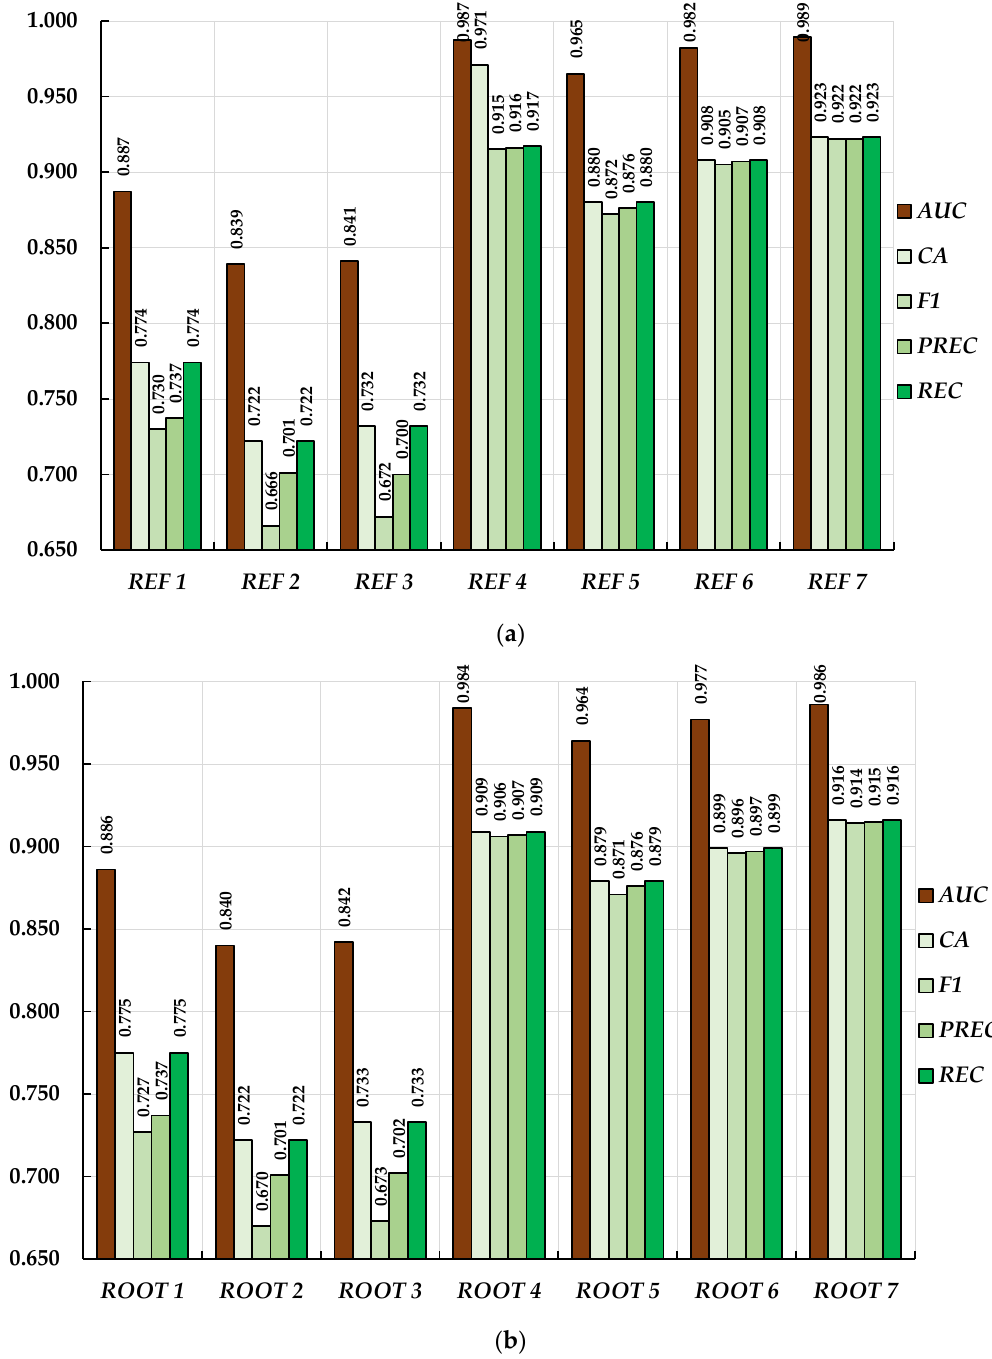
Figure 3. General classification performance metrics computed for the signals characterizing the FULL resolution: ( a ) classification performance metrics for the REF signals, ( b ) classification performance metrics for the ROOT signals. Legend: REF1—REF7 and ROOT1—ROOT7 have the meanings given in Table 3, AUC —area under curve, CA —classification accuracy, F1 —harmonic mean of PREC and REC , PREC —precision, REC —recall.